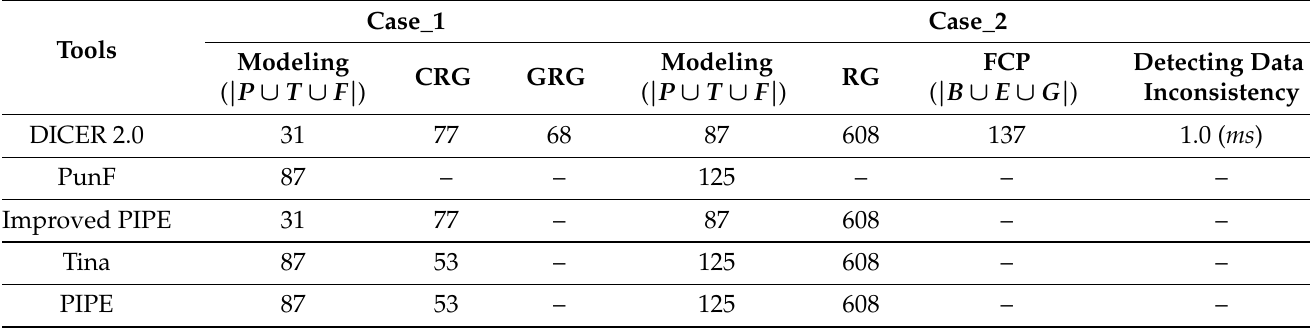
Table 6. The comparison experiments on the performance of DICER 2.0 and other Petri net tools. Case_1 Case_2 Tools